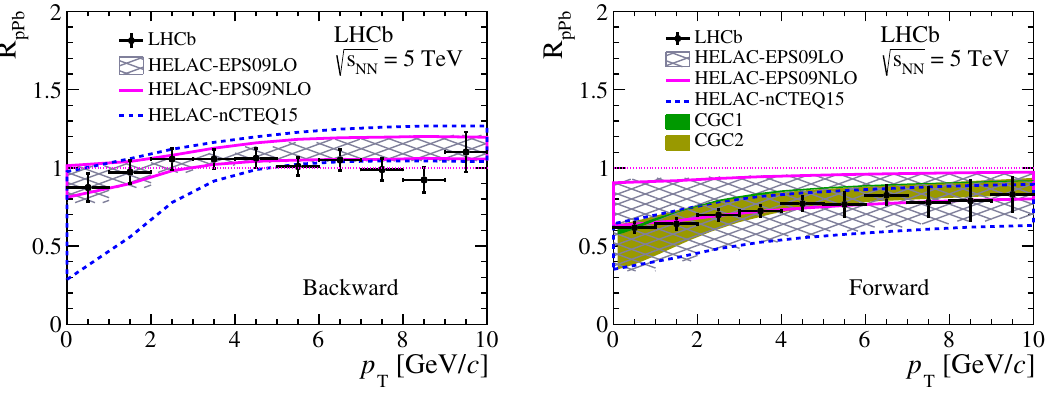
Figure 5 . Nuclear modi(cid:12)cation factor R p Pb as a function of p T for prompt D 0 meson production in the (left) backward data and (right) forward data, integrated over the common rapidity range 2 : 5 < j y (cid:3) j < 4 : 0 for p T < 6 GeV =c and over 2 : 5 < j y (cid:3) j < 3 : 5 for 6 < p T < 10 GeV =c . The uncertainty is the quadratic sum of the statistical and systematic components. The CGC predictions marked as CGC1 [67] and CGC2 [68] are only available for the forward region.